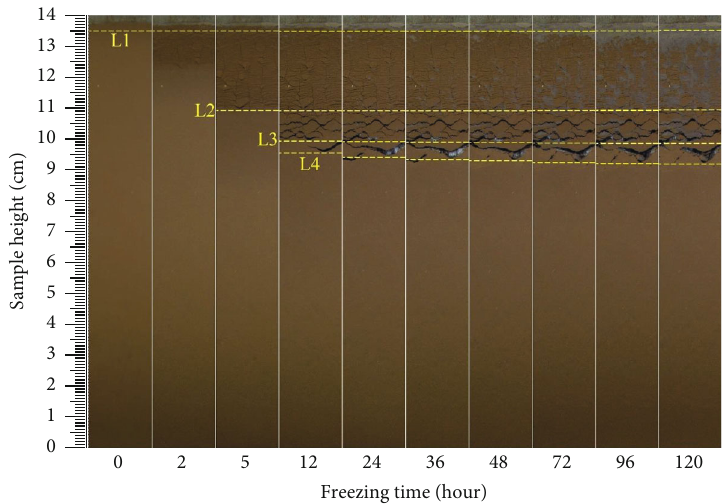
Figure 6: The cryostructure in the vertical pro fi le of the sample